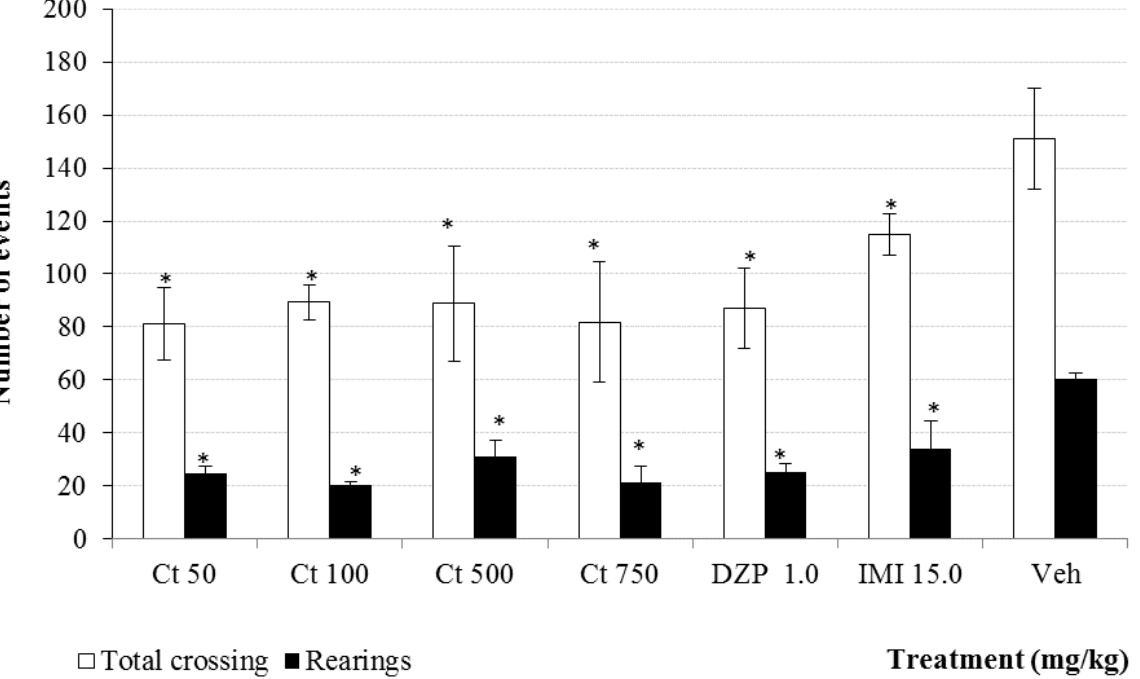
Figure 4. Effect produced by different doses (50, 100, 500 and 750 mg/kg, p.o. ) of Ct extract from C. tenuiflora (Ct) on spontaneous motor parameters: total crossing and rearings in the OFT. The results are presented as means ± SD. * p < 0.05, as compared with the control group. (ANOVA one way following by Dunnet test); n = 6 mice per group. DZP = Diazepam, IMI = Imipramine, Veh = Tween 20,